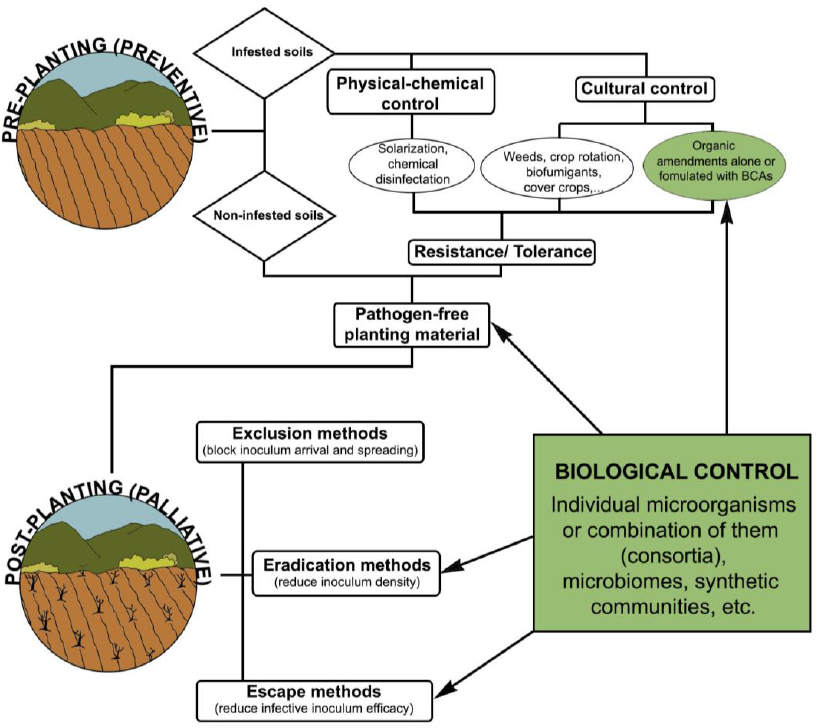
Figure 3. Biological control measures within and integrated management strategy of Verticillium wilt of olive (based on López-Escudero and Mercado-Blanco [1]).